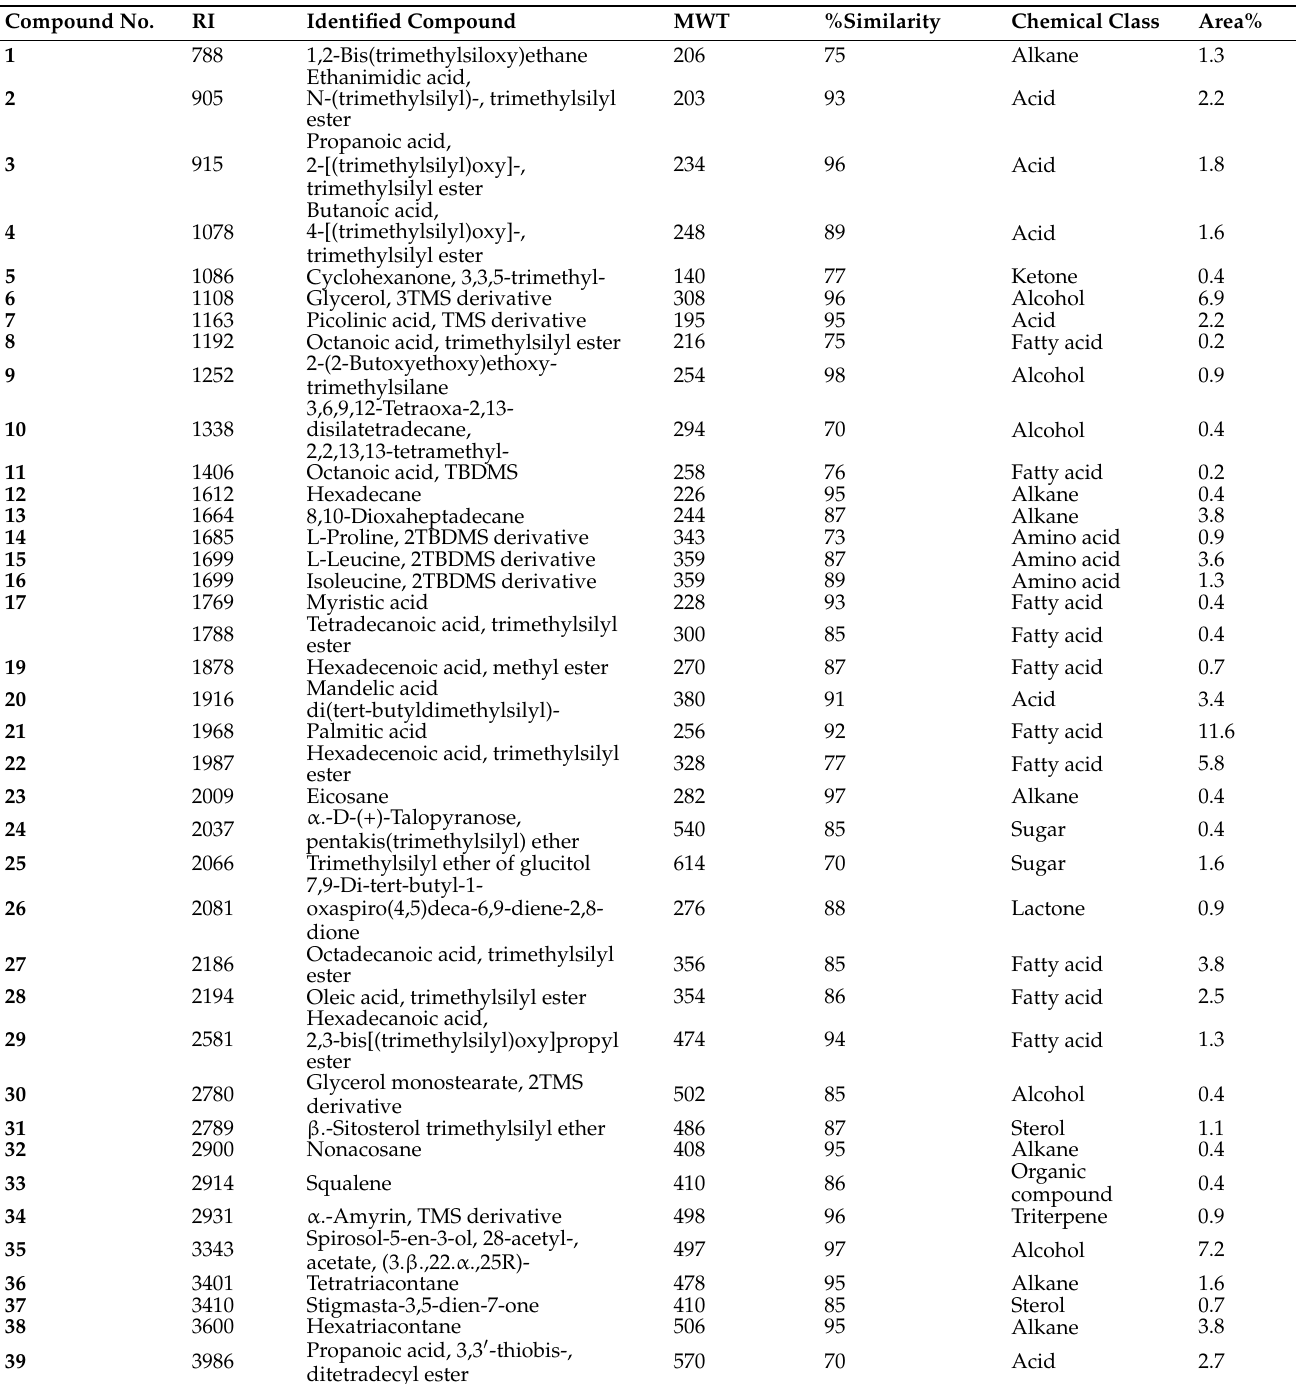
Table 2. Composition of the dichloromethane extract from the O. europaea leaves according to the GC-MS analysis. Compound No.